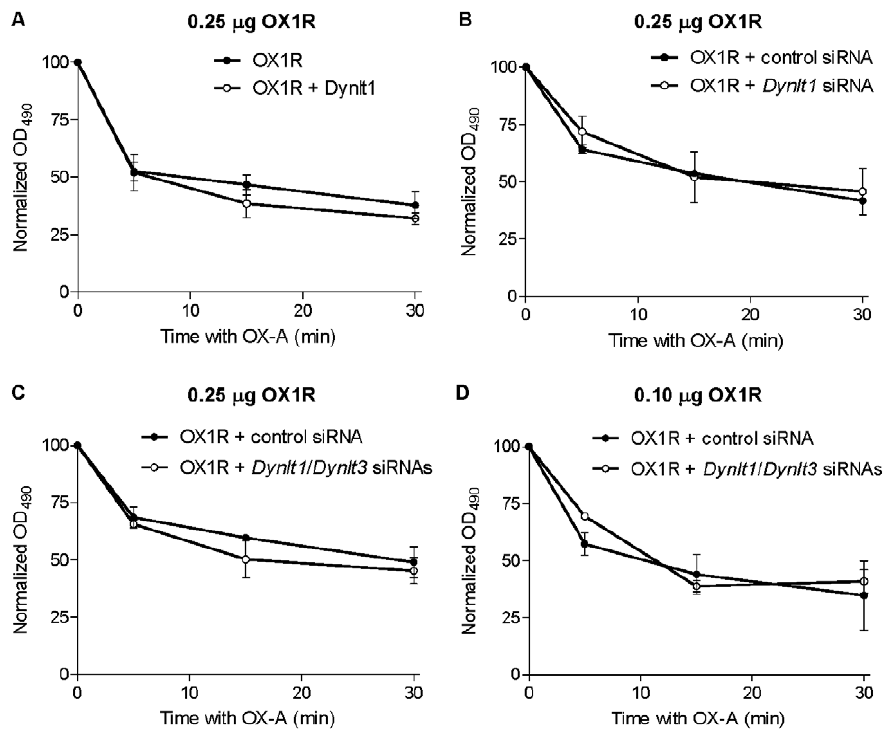
Figure 7. Agonist-induced internalization of OX1R in presence or down-regulation of Dynlt1/Dynlt3. Cell surface detection of OX1R was measured by ELISA. HEK293 cells were transfected with either 0.1 (A) or 0.25 m g (B, C, D) control pSG5-V5-His or pSG5-V5-His-OX1R, in combination with: ( A ) pCS2-Myc or pCS2-Myc-Dynlt1, ( B ) 10 nM of either control siRNA or Dynlt1 siRNA (80% down-regulation), or ( C, D ) either 20 nM control siRNA or a combination of Dynlt1 and Dynlt3 siRNAs at 10 nM each (75% and 80% down-regulation, respectively). Cells were then treated with OX-A for up to 30 min. Normalized OD values refer to OD values that have been corrected (background-subtracted) and then expressed relative to basal conditions (% of value before stimulation for each condition). For all panels, there is maximum OX1R at the membrane at basal conditions (0 min; without OX-A) and the receptor is internalized (represented by loss at the membrane) after OX-A treatment. Results represent the mean 6 SEM of 3 experiments, each performed in triplicate (except for panel D; results represent the mean 6 SEM of 2 experiments). There is no statistical significance for the effect of over-expressing or down-regulating Dynlt1 and/or Dynlt3 as assessed by two-way ANOVA.